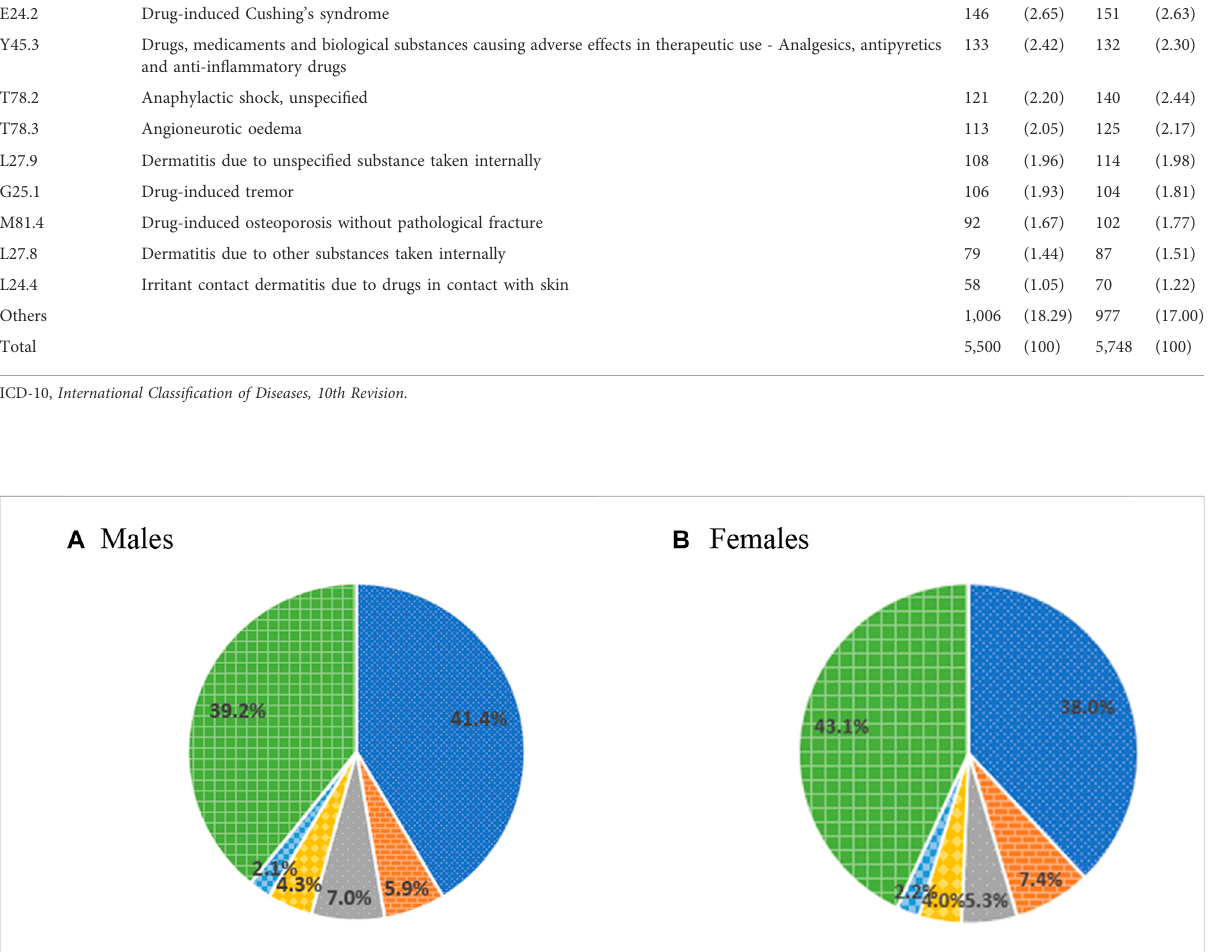
prevalence in females. The female-to-male ratio of prevalence of ADEs was signi fi cantly higher than 1.0 in the age group of 65 – 69 years and the age group of 75 – 79 years ( p < 0.05;